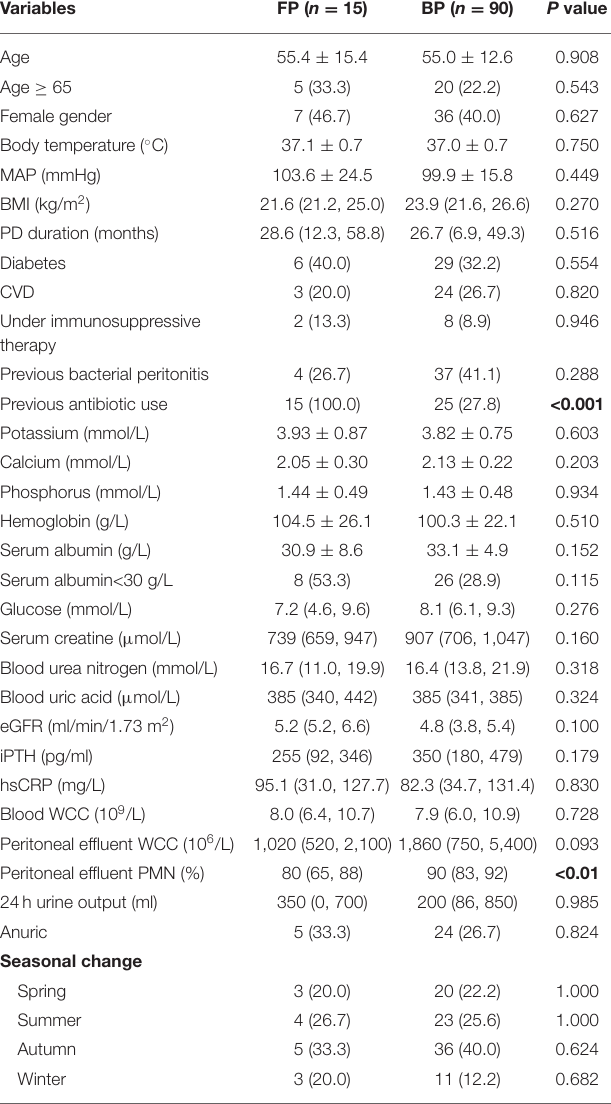
TABLE 3 | Comparison of patients with fungal versus bacterial peritonitis (1:6 ratio matching) [Mean ± SD, Median (P25, P75), n